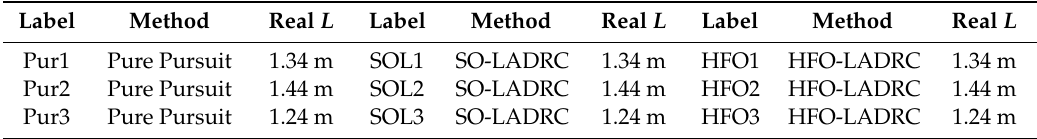
Table 2. Method and real wheelbase L